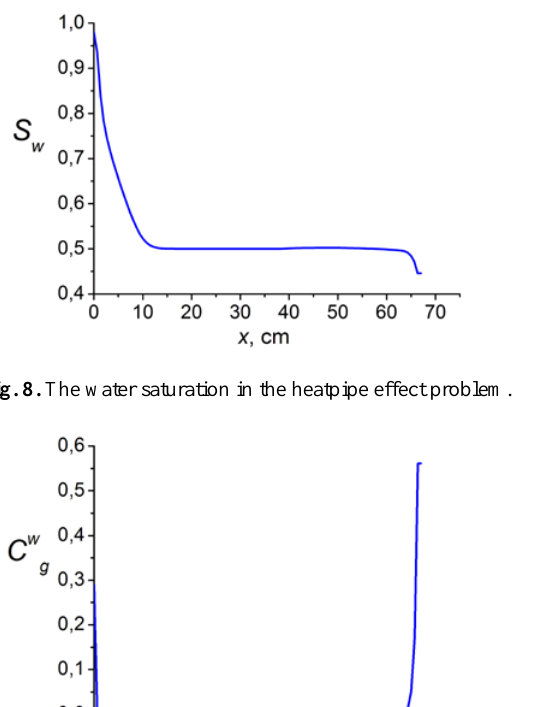
Fig. 5. The oil saturation field.